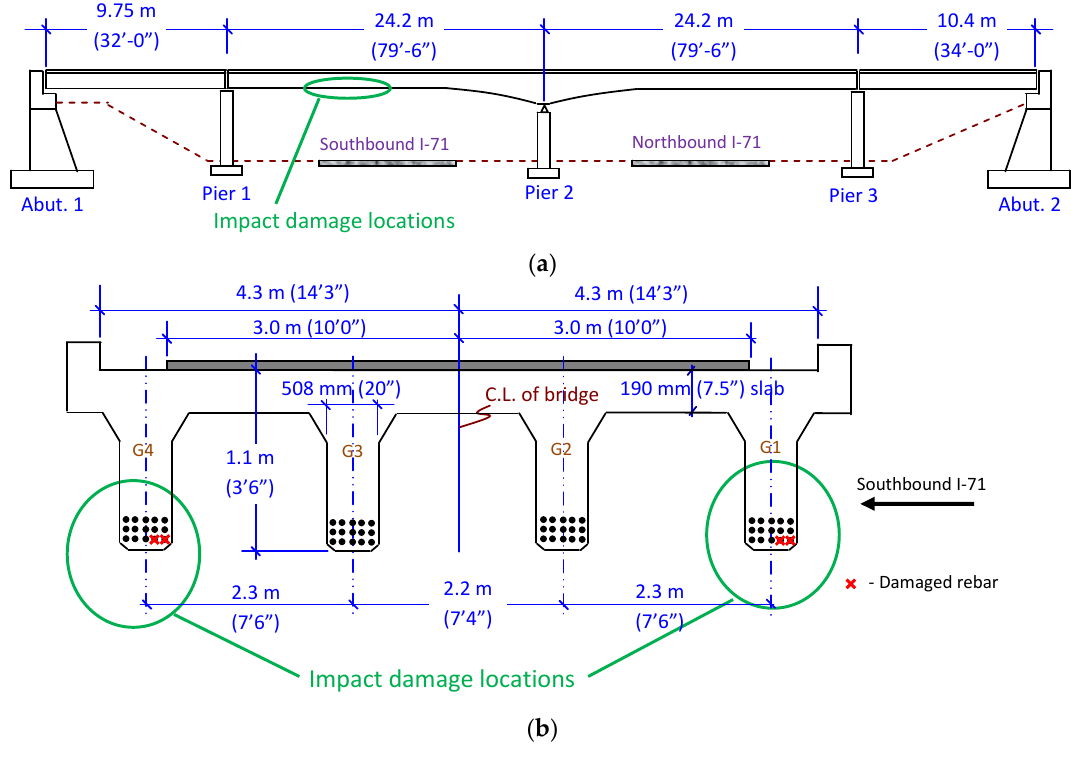
Figure 2. ( a ) General layout of the bridge; ( b ) Cross section of the bridge at impact location. Both exterior girders (G1, G4) over the right lane were impacted, producing spalled concrete and bent reinforcing bars. At the point of impact, the bottom rebar mat of both RC girders consisted of five rebars, each 35.8 mm (1.41 in) in diameter, of which two were bent and yielded (Figure 3). The damaged reinforcement represented 13.3% of the total reinforcing steel available to resist positive bending. Several stirrups for shear reinforcement were also severed during the impact. On both